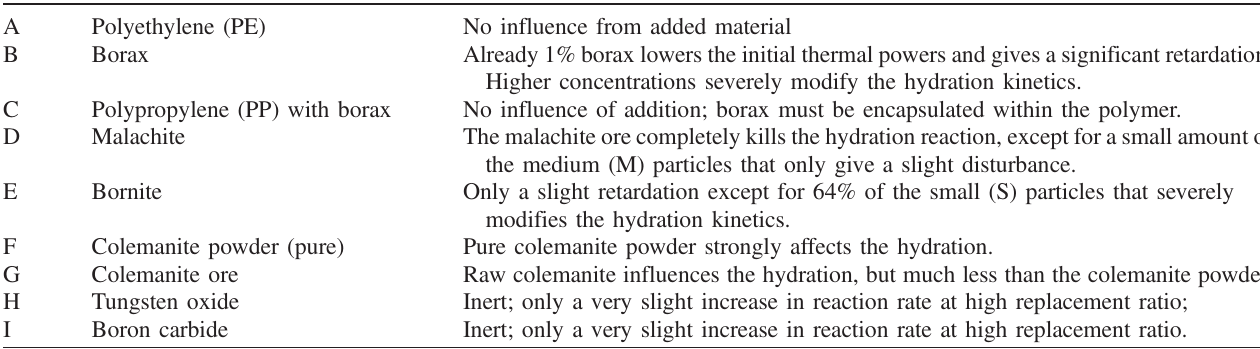
TABLE II. The materials used and the result of the calorimetric measurements. The lettering corresponds to Fig.